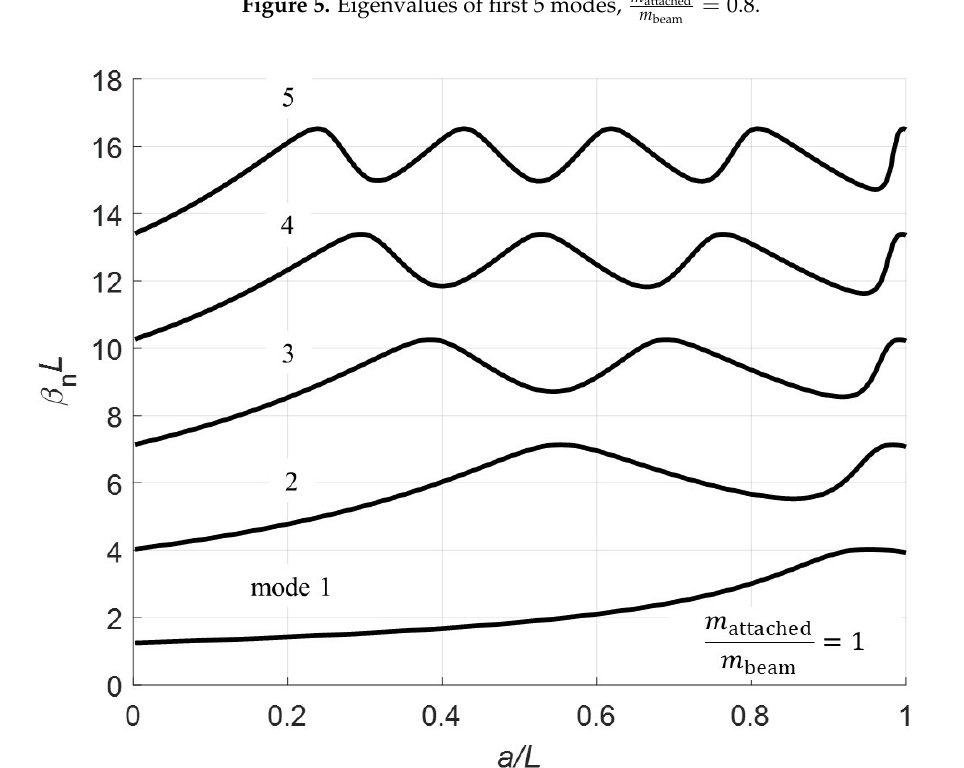
Figure 5. Eigenvalues of first 5 modes, m attached